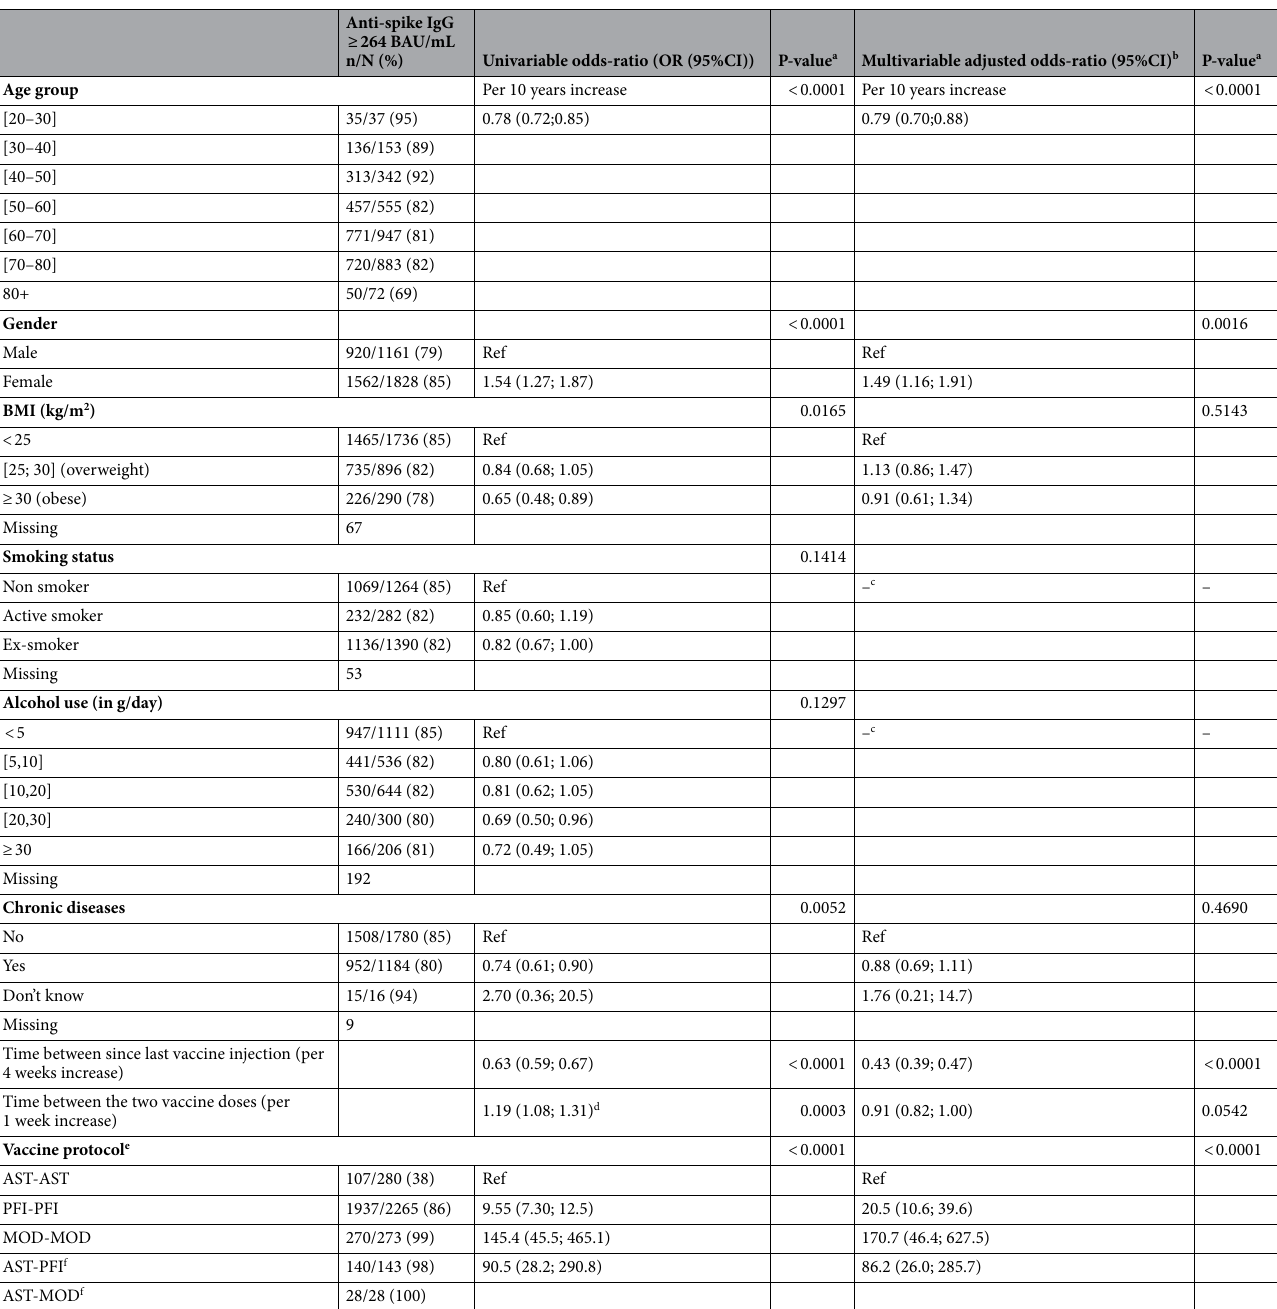
Table 2. Factors associated with an anti-spike IgG titer ≥ 264 BAU/mL at the follow-up in participants with two vaccine doses and no diagnosis of SARS-CoV-2 infection. a P-Value of the type 3 Wald Chi-Square test for the association between the covariate and an anti-spike IgG titer ≥ 264 BAU/mL. b 2872 were selected in the multivariable logistic model; 117 were deleted due to missing information on some covariates. c Not included in the multivariable model because not significant in univariable analysis. d Adjusted on vaccine protocol. e AST = ChAdOx1 nCoV-19; MOD = mRNA-1273; PFI = BNT162b2. f These two groups were combined for OR